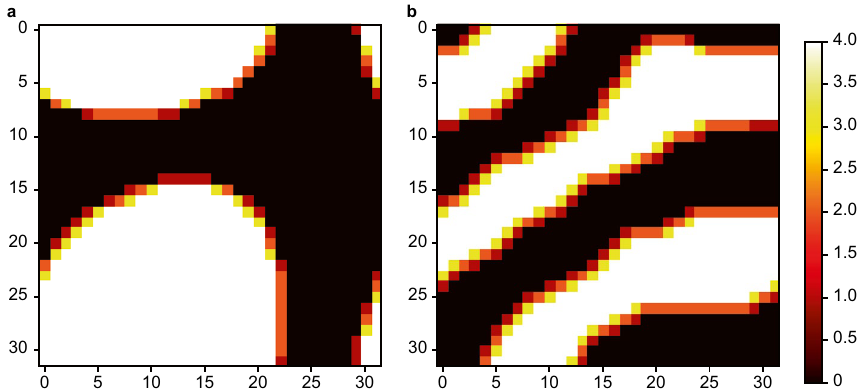
Figure 3. Results of a phase-field analysis in the case of f = 0.5 at the equilibrium state for a quantum annealing simulator. ( a ) Without Ohta-Kawasaki energy and ( b ) with Ohta-Kawasaki energy. In ( b ), the observed microstructure corresponds to that in the phase diagram, i.e., a lamellar structure.